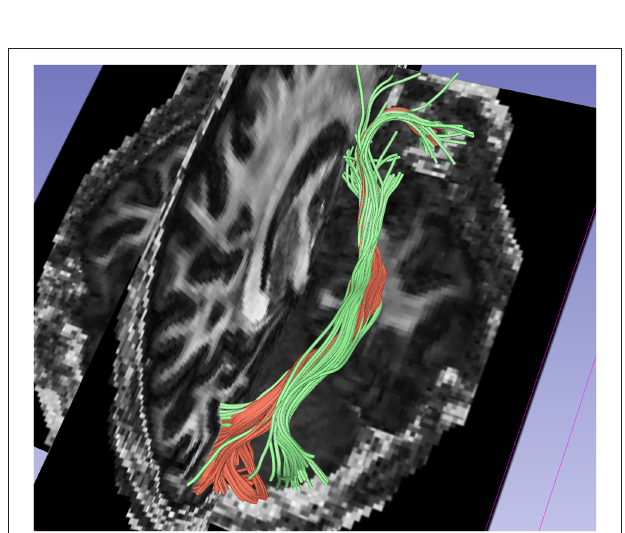
FIGURE 6 | Comparision of results between 1-fiber NODDI model tractography(red) and 2-fiber NODDI model tractography(green) for the IOFF fibers.